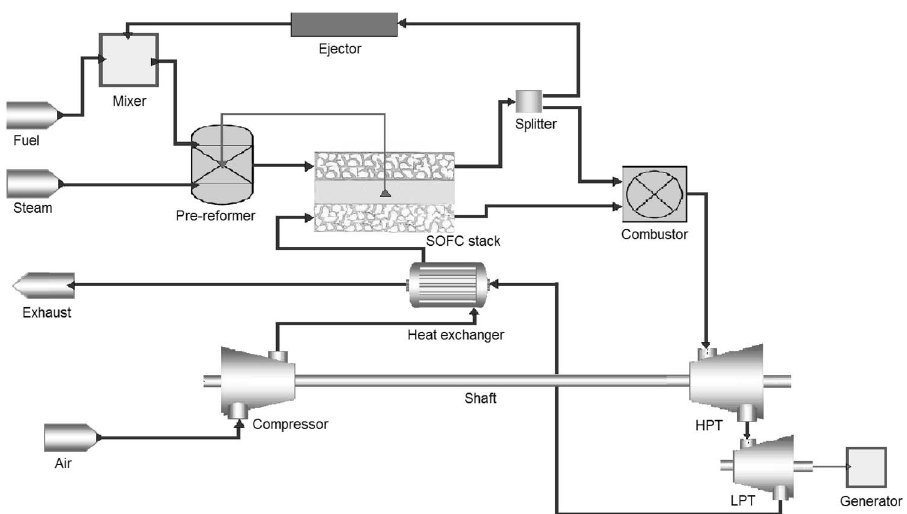
Figure 1. Hybrid system: double shaft